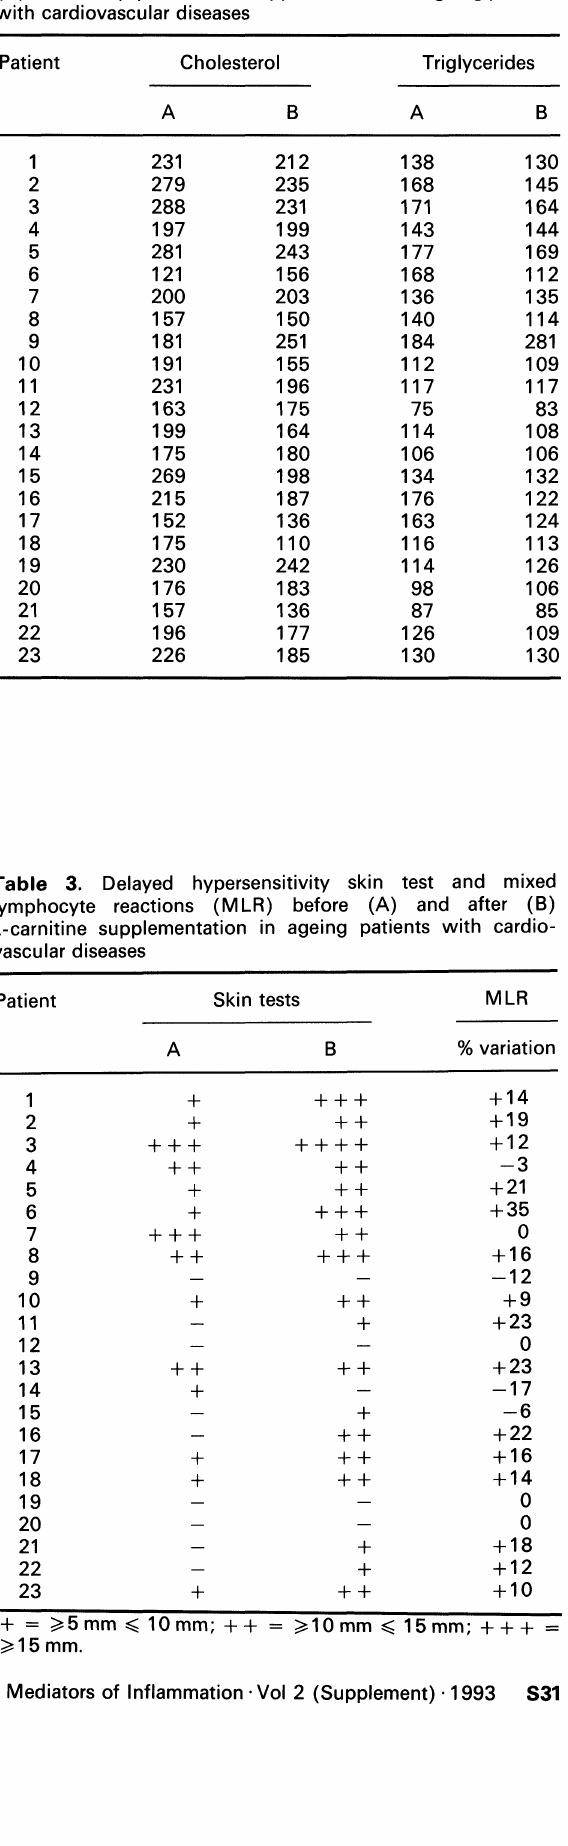
Table 2. Serum levels of cholesterol (normal range" 160-330 mg/dl) and triglycerides (normal range: 40-160 mg/dl) before